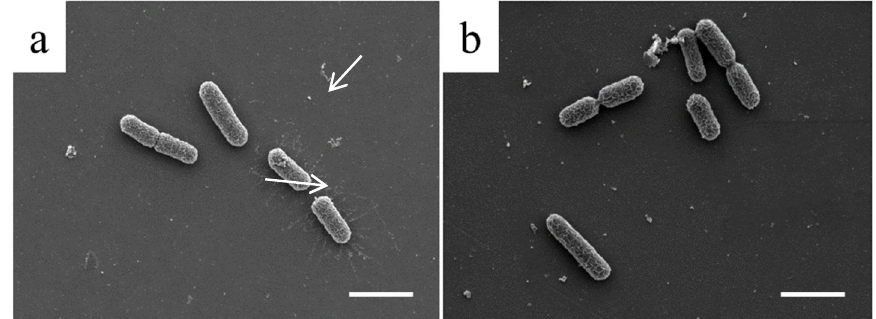
Figure 8. Magnified SEM images of E. coli adhesion on Ti ( a ) and Ti_PEG_5_4 ( b ), showing the presence of fimbriae in the bacteria adhered on the Ti sample (white arrows), but not on the Ti_PEG_5_4 sample. Scale bar represents 2 µm.